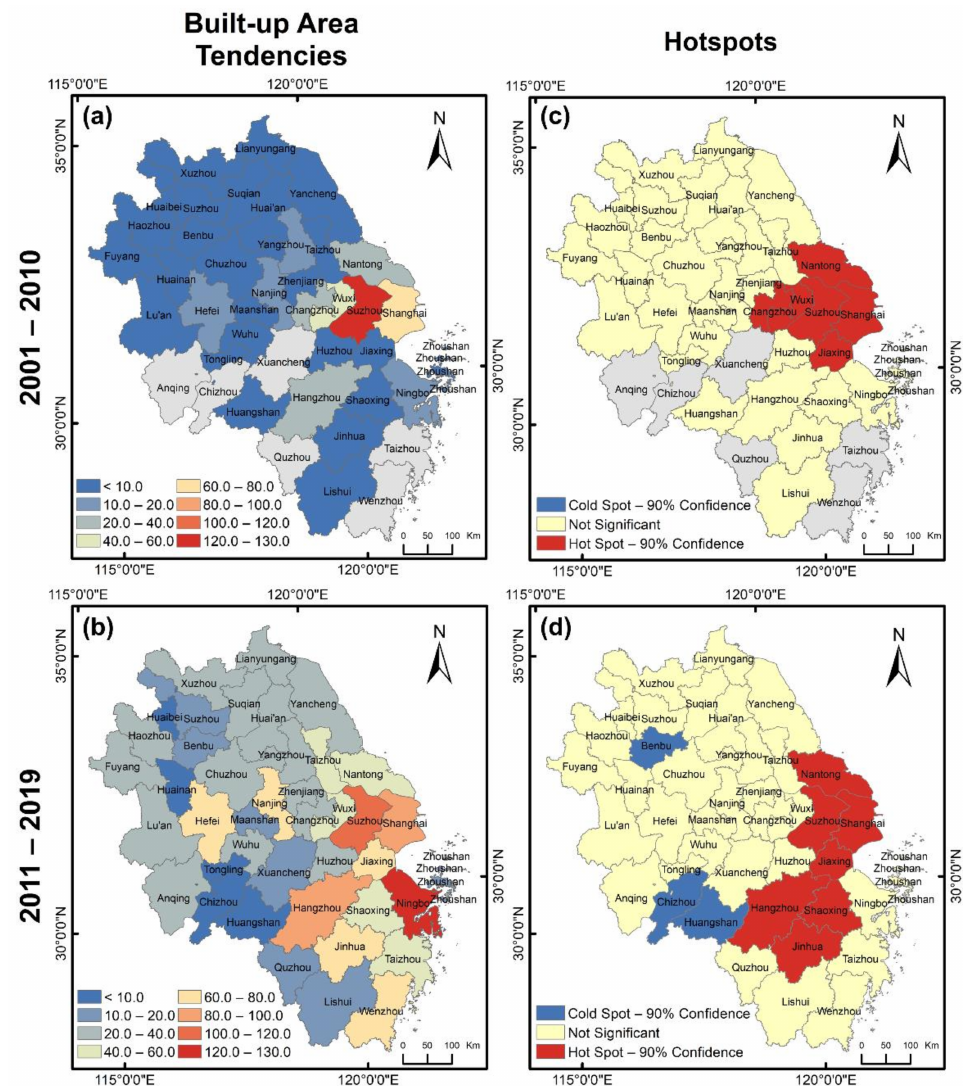
Figure 5. Tendencies and hotspot detection in 2001–2010 and in 2011–2019 over the Yangtze River Delta: ( a , b ) linear regression tendencies of the built-up area and ( c , d ) hotspot analyses from the linear regression